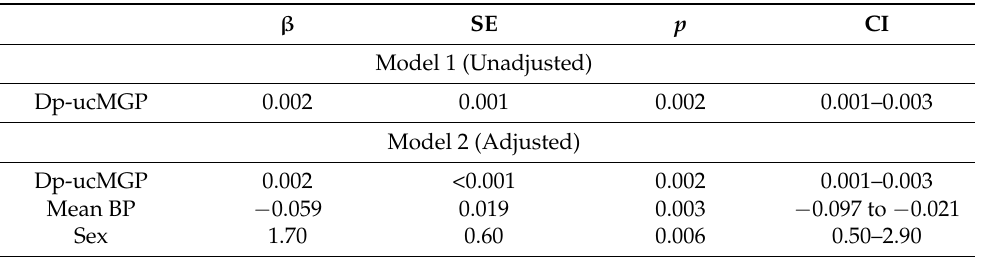
Table 5. Multiple regression analysis (stepwise forward) in 158 CKD patients with NLR as the dependent variable. β SE